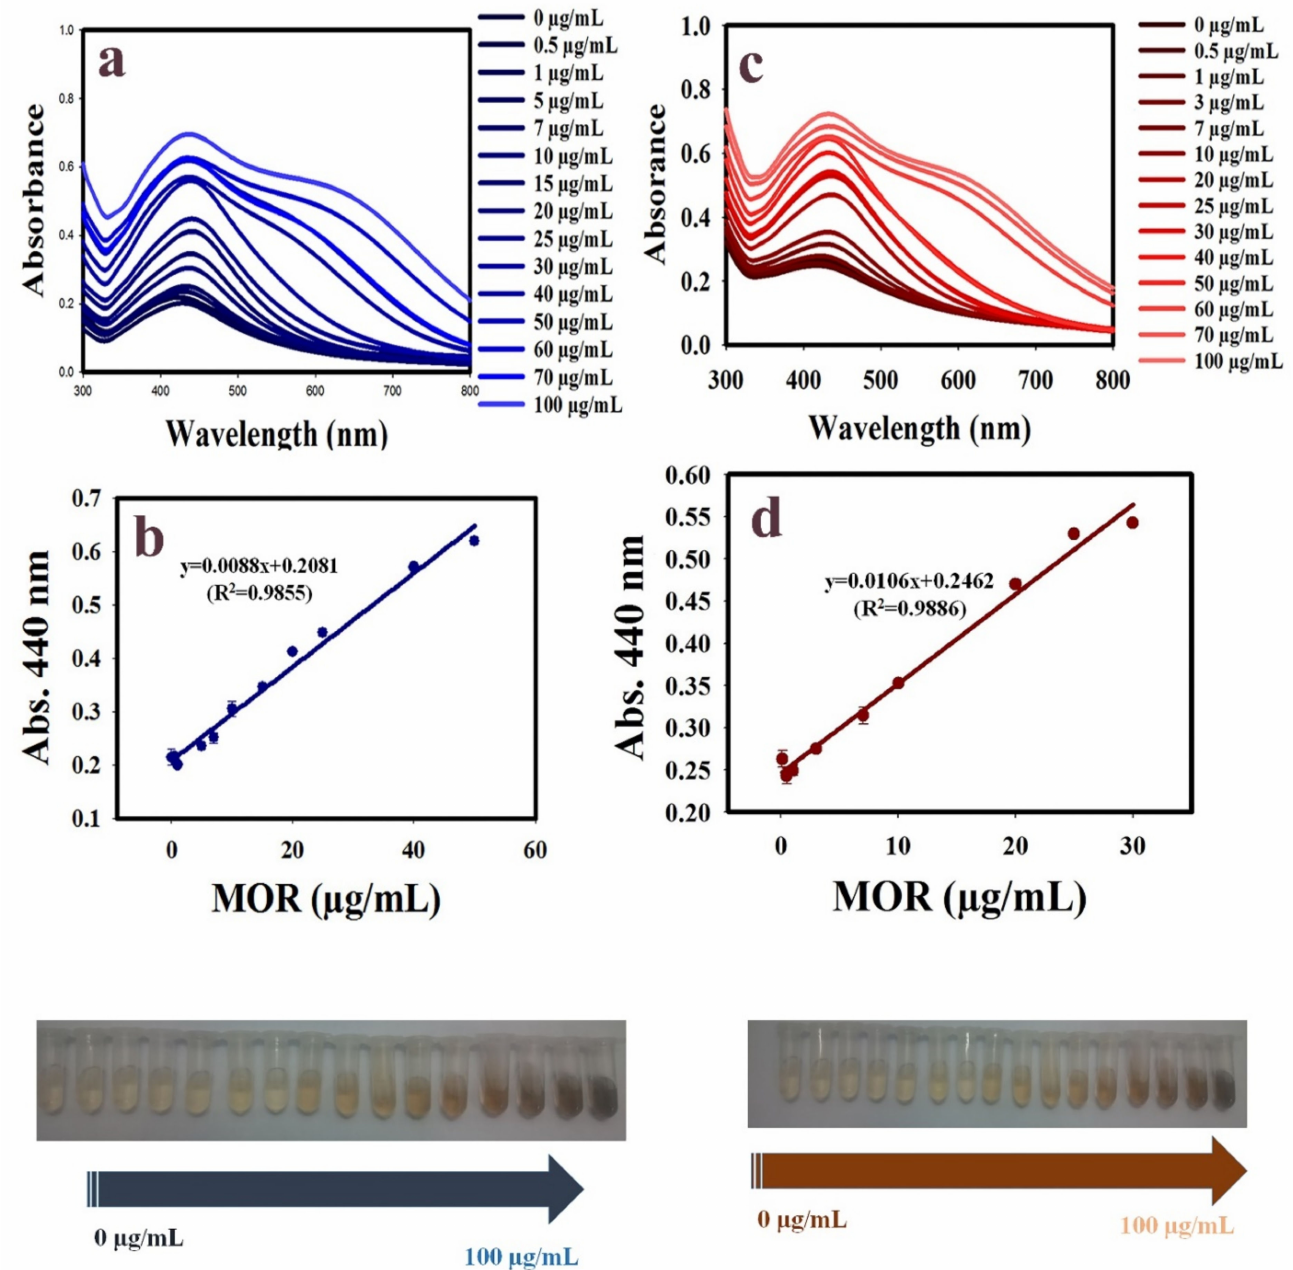
Figure 8. UV-visible spectra of ( a , b ) Au@Ag (P) solutions with different concentrations of MOR, calibration graphs for the quantification of MOR by using Au@Ag (P) as a colorimetric probe, and photographic images of Au@Ag (P) in the concentration range of 0 − 100 µ g/mL; ( c , d ) Au@Ag (B) solutions with different concentrations of MOR, calibration graphs for the quantification of MOR by using Au@Ag (B) as a colorimetric probe, and photographic images of Au@Ag (B) in the concentration range of 0–100 µ